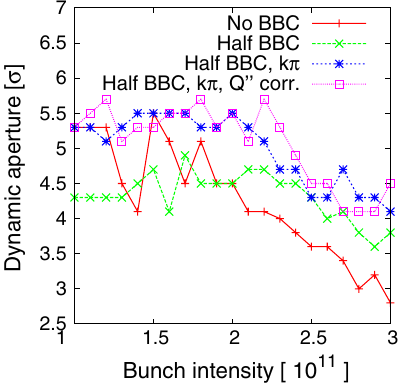
FIG. 9. Dynamic apertures of half head-on beam-beam com- pensation with the betatron phase advance adjustment and the global second order chromaticity correction.